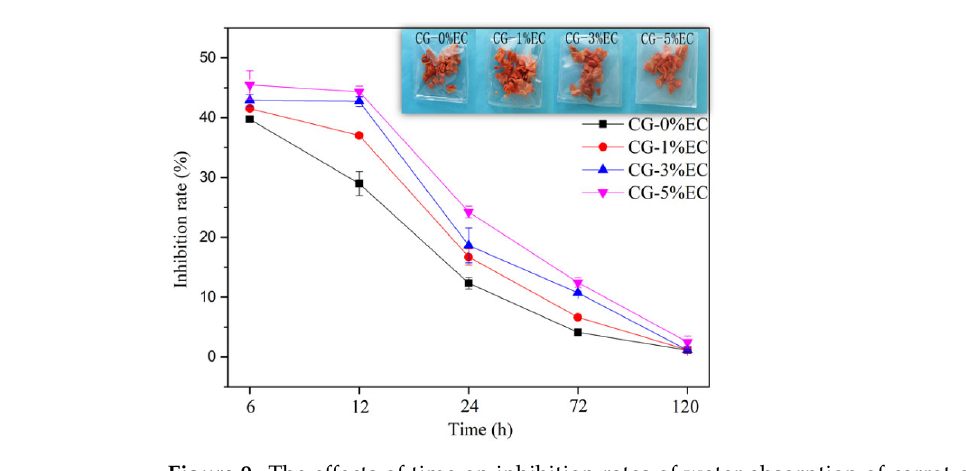
11 of 13 Figure 8. TG and DTG Analysis of raw materials and films. 3.8. Application of Films in Packaging Dried Carrot Cube The inhibition rates of the films are shown in Figure 9. After 12 h, inhibition rates increased from 28.98% to 43.34% as EC content increased from 0% to 5%. In the same pe ‐ riod, CG ‐ 5%EC presented the highest inhibition rate, which is consistent with the WVP